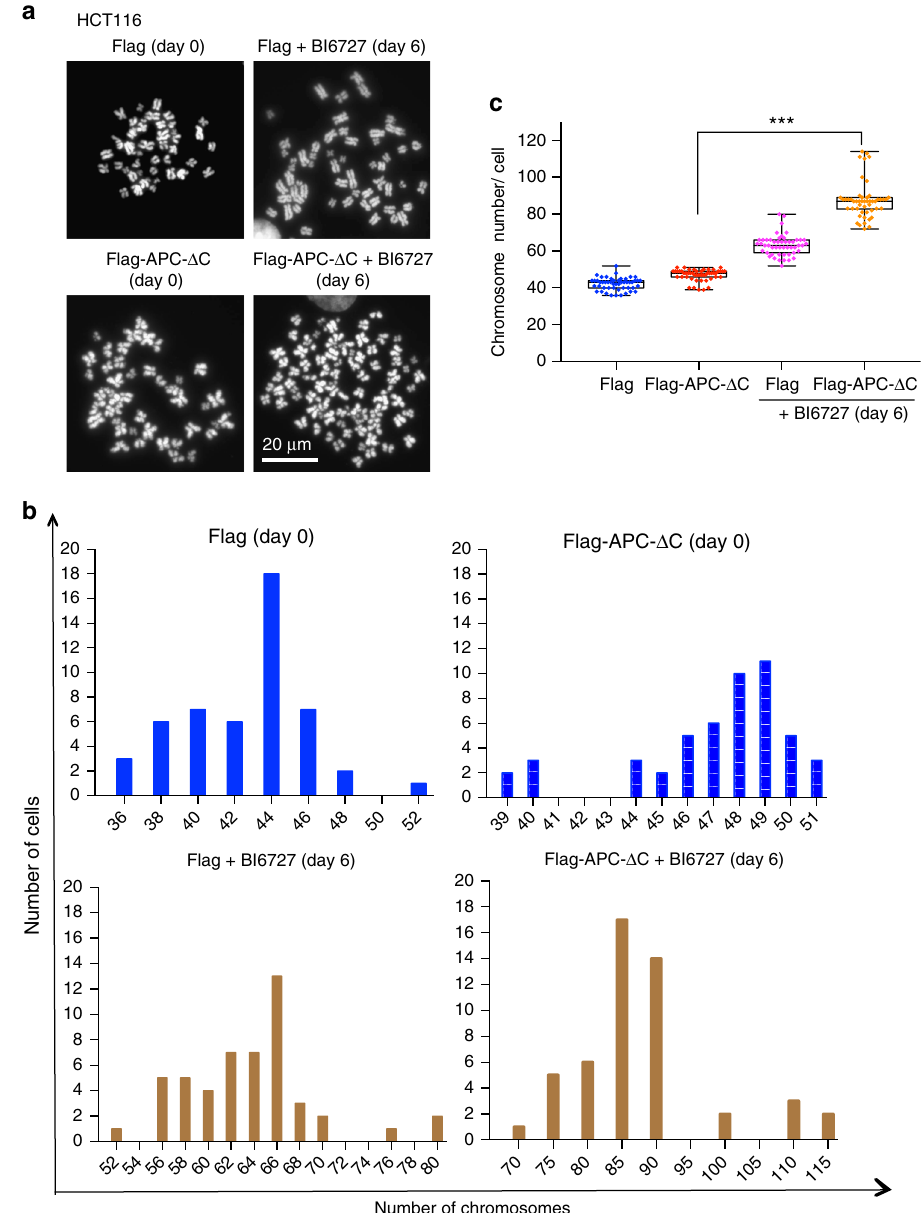
Fig. 5 Analysis of chromosomal aberrations in BI6727-treated, APC- Δ C-expressing colon cells. a Following the incubation with BI6727 for 48 h and subsequent release into fresh medium for 6 days, metaphase spreads of HCT116 cells with or without APC- Δ C-expression were prepared and the chromosomes were stained with Hoechst. Scale bar: 20 µ m. b The histogram plotting of the distribution of chromosome numbers at day 0 and day 6 is shown. c Quanti fi cation of the number of chromosomes in 500 HCT116 cells with or without APC- Δ C-expression incubated in the presence or absence of BI6727 (100 nM) for 48 h. (means ± s.d., n = 3, for each treatment). *** P < 0.001, Student ’ s t -test, unpaired and